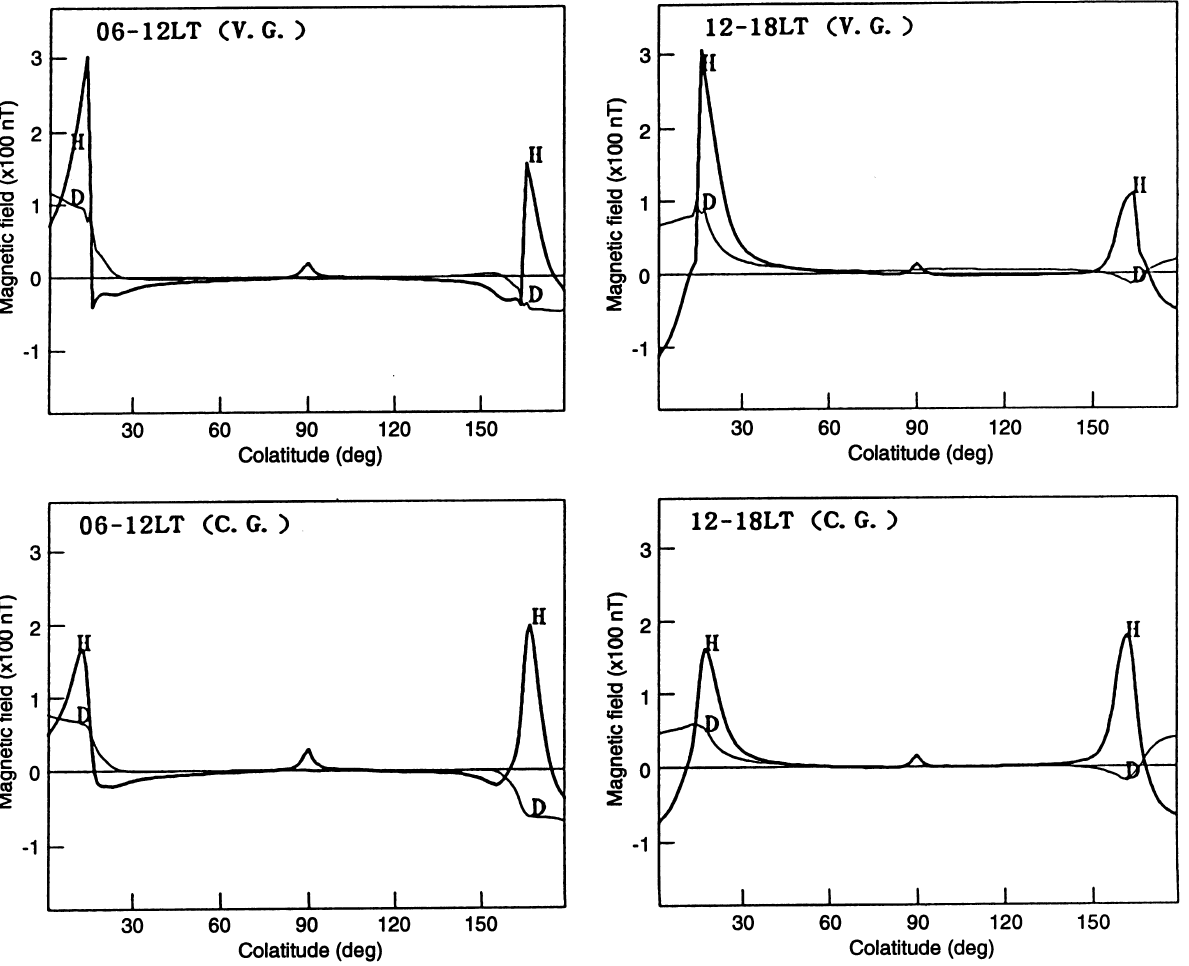
Fig. 11. Average latitudinal variations of H ( thick lines ) and D ( thin lines ) component magnetic fields of the voltage ( upper panels ) and current ( lower panels ) generators, for two local